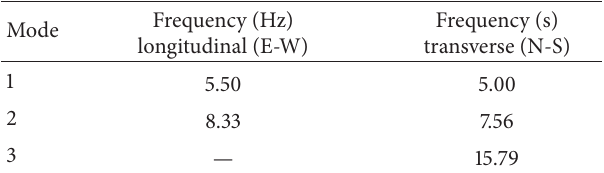
Table 5: Extracted the frequencies from CWT method.